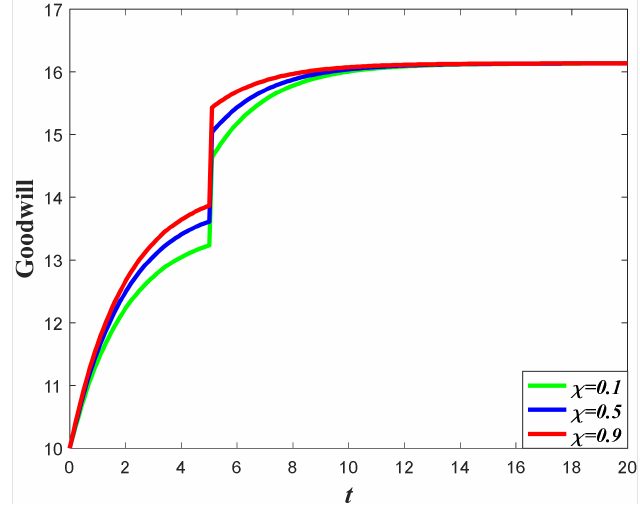
Figure 5. Impacts of χ on goodwill level.